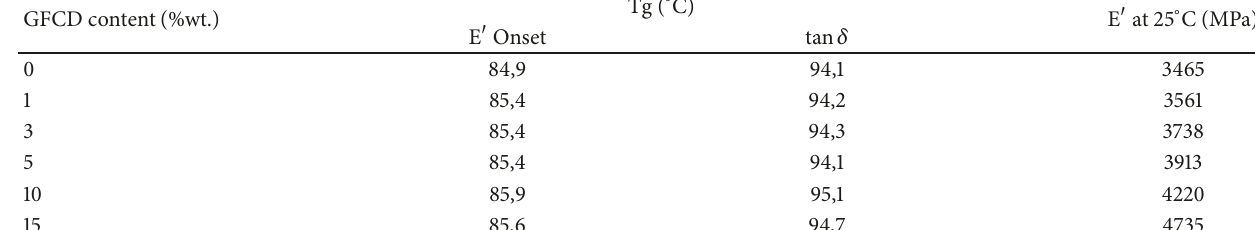
Table 2: Summarising the glass transition temperature values and storage modulus values of the PVC/GFCD composites. GFCD content (%wt.)